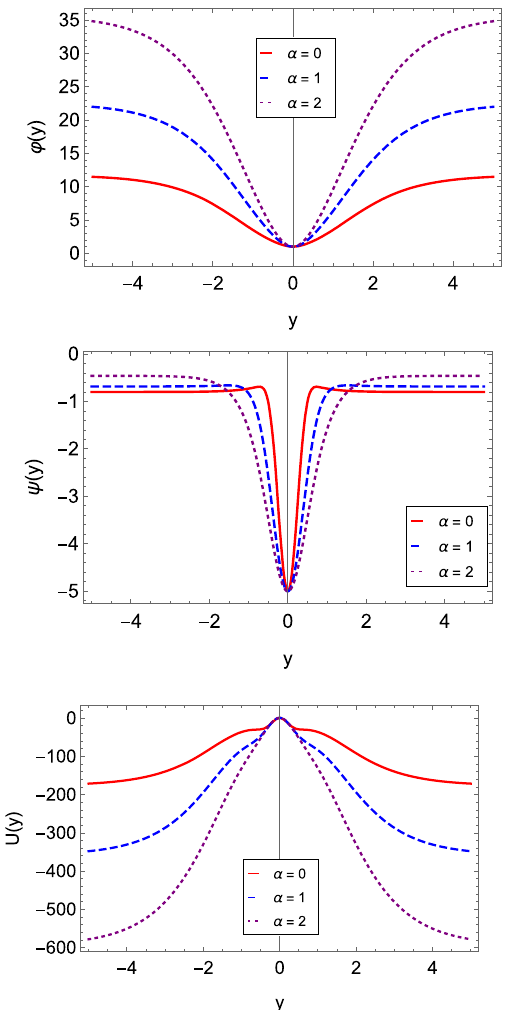
Fig. 2 Numerical solutions for ϕ( y ) (top panel), ψ( y ) (middle panel) and U ( y ) (bottompanel)fromEqs.(23),(26),and (28)with ϕ 0 = U 0 = k = φ 0 = 1, ψ 0 = − 5, A 0 = 4 / 9, and A 1 = − 1 / 9, for different values of